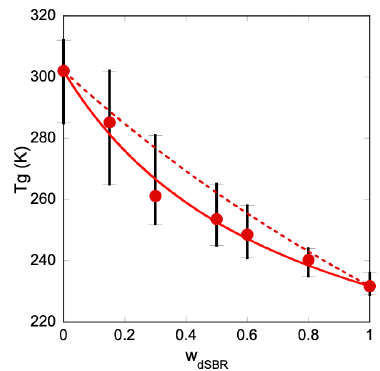
Fig. 2 . Composition dependence of the glass-transition temperature 𝑇 " (inflection point of the specific heat). Error bars span between the of 𝑇 4 and 𝑇 6 determined by DSC. Dashed line shows the Fox prediction, and solid line the Gordon-Taylor description.